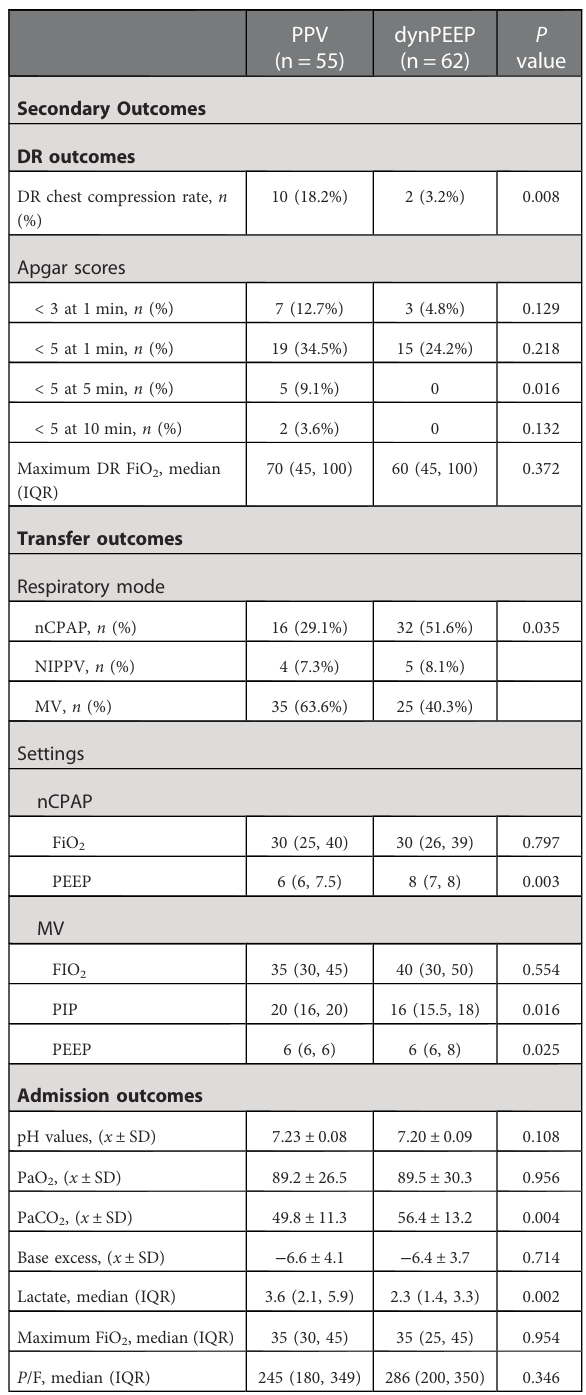
TABLE 3 The secondary outcomes (DR, transfer, and admission) of preterm infants with gestational Age less than 30 weeks who received PPV or DynPEEP in the